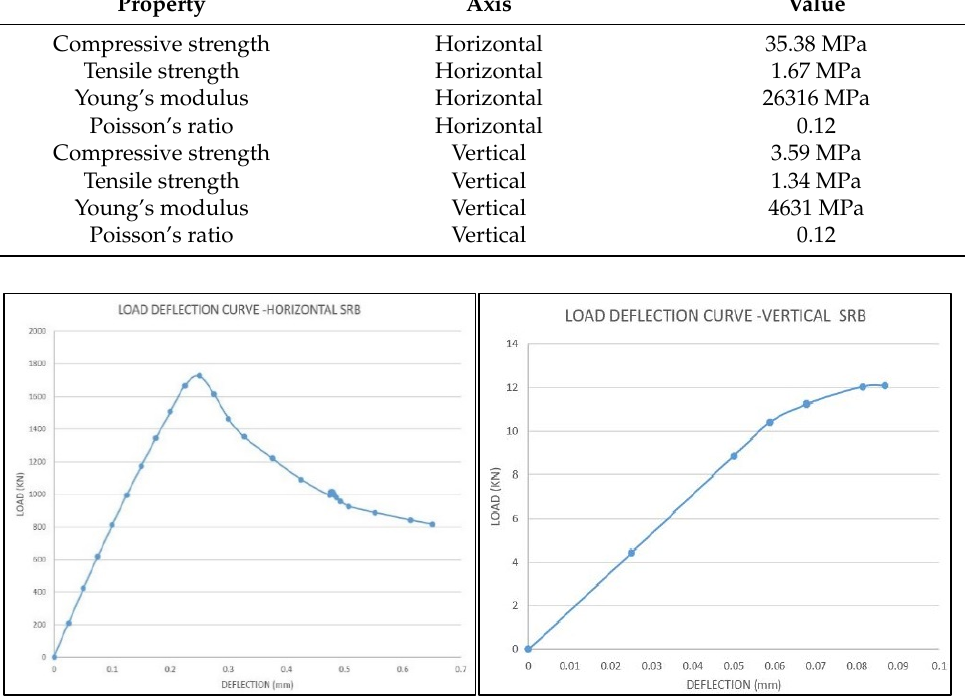
Figure 33. Load deflection curve for horizontally and vertically loaded sustainable red mud